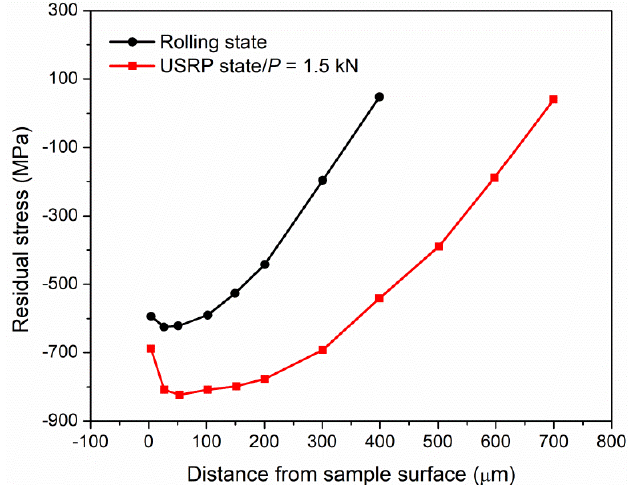
Figure 12. Residual stress distribution along the cross-section of the rolling and USRP-treated specimens with a static load P of 1.5 kN .